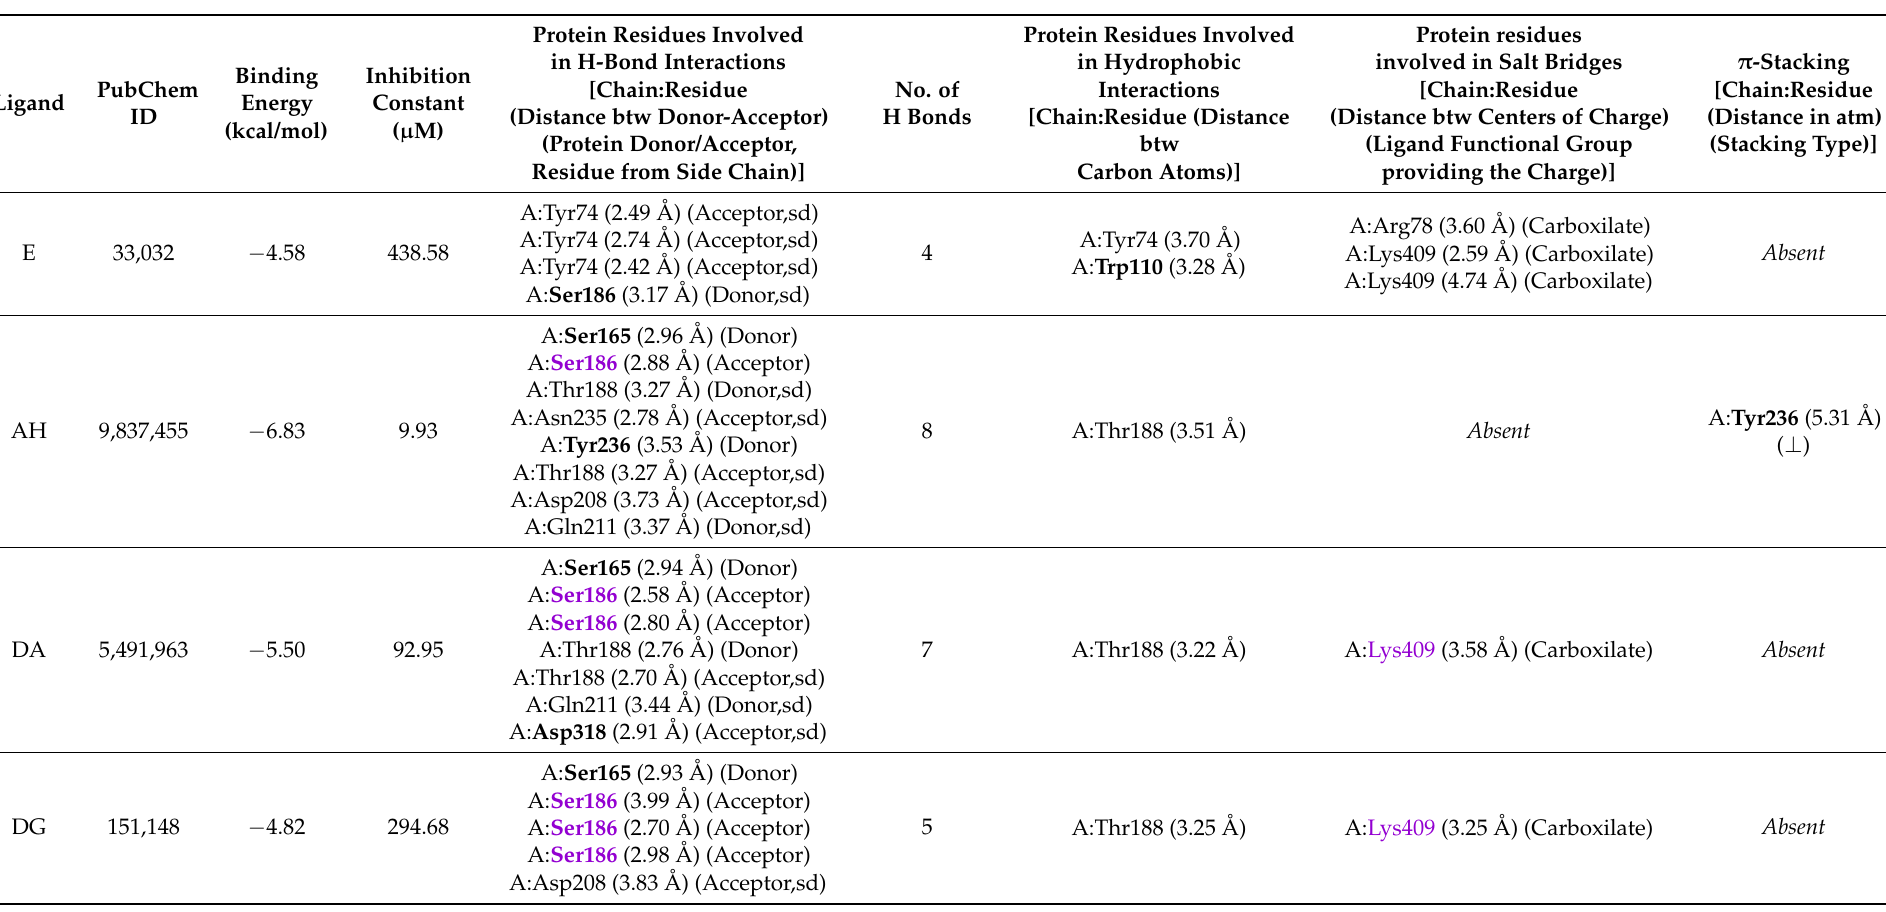
Table 4. Homo sapiens open–open conformation (PDB ID: 3KS9) of mGluR1 residues involved in docking interactions with glutamic acid and the umami dry-cured ham dipeptides of this study, with docking